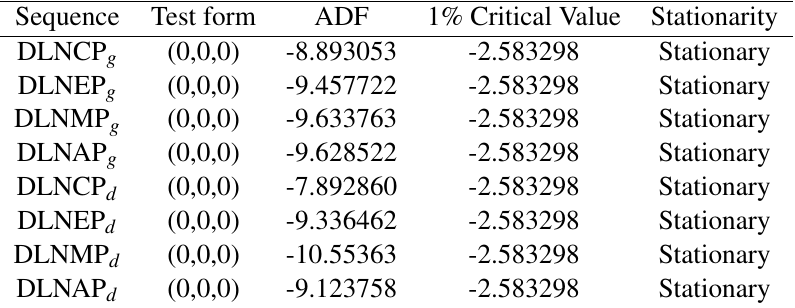
Table 1 ADF stationarity test of variables